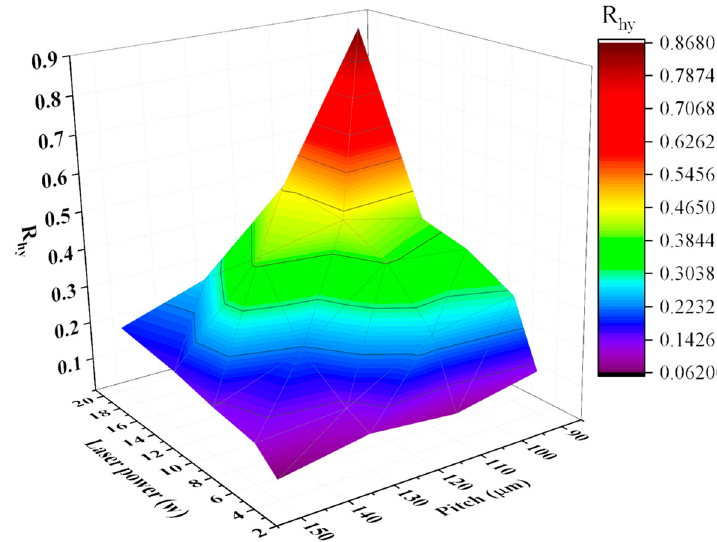
Figure 7. 3D colormap of the product fingerprint (R hy ) as a function of laser power and pitch of Gaussian hole.